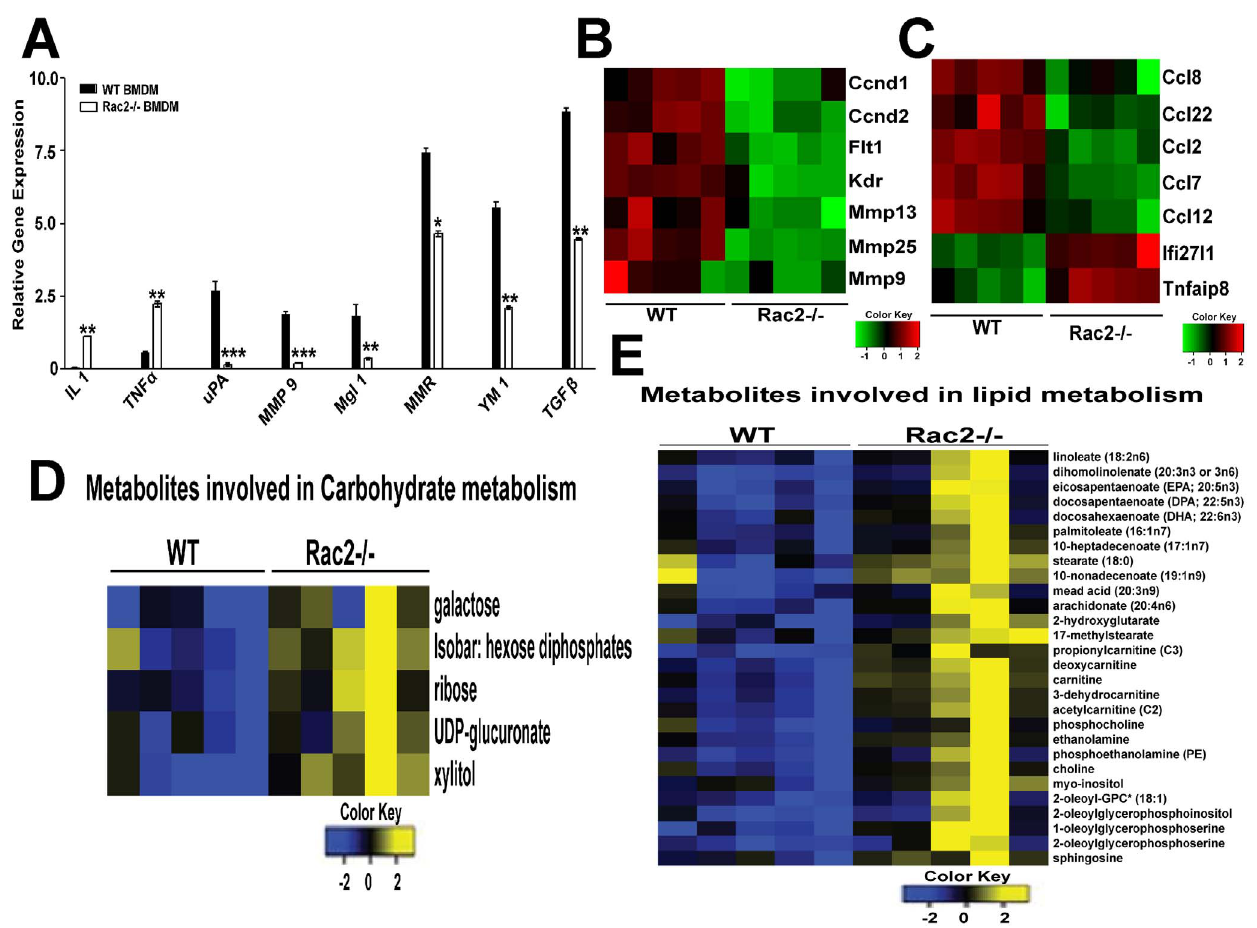
Figure 5. Rac2 promotes differentiation of M2 macrophages invitro . (A) Quantitative PCR analysis of mRNA for IL 1, uPA, TNF a , MMP9, Mgl1, MMR, YM1 and TGF- b in BMDMs isolated from WT and Rac2-/- mice and cultured in MCSF in vitro . Values are mean 6 SEM (n=3-4 mice). Statistical significance is assessed by two sample t -test where *denotes P , 0.05, ** denotes P , 0.01 and *** denotes P , 0.001. (B) & (C), Heat map generated from microarray analysis of BMDMs isolated from WT and Rac2-/- mice (n=5 in each group) as described in Materials and Methods. Colors illustrate fold changes, Red: up-regulation; green: down-regulation; black: no change. The bar code on the bottom represents the color scale of the log 2 values. The differential expression of genes related to cell cycle, angiogenesis and invasion are shown in B and M1-M2 polarization are shown in (C). (D) & (E), Heatmap representation of metabolites across BMDMs from WT (n=5) and Rac2-/- (n=5) mice. Shades of yellow represent elevation of a metabolite and shades of blue represent decrease of a metabolite relative to the median metabolite levels (see color scale). Colors illustrate fold changes, Yellow: up-regulation; blue: down-regulation; black: no change. Data shows higher expression of metabolites related to carbohydrate (D) and lipid metabolism (E) in Rac2-/- BMDMs.